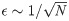
Imprecise balance under optogenetic stimulation.a) Schematic. A population of recurrently connected excitatory (red) and inhibitory (blue) spiking neuron models receive synaptic input from an external population (X; green) of Poisson-spiking neurons. Optogenetic stimulation of excitatory neurons was modeled by an extra inward current to the excitatory population at 5s. b) Spike rasters from 50 randomly selected excitatory (red) and inhibitory (blue) neurons from recurrent network. c) Average firing rate of excitatory (red) and inhibitory (blue) neurons in the recurrent network from simulations (light solid), from the balanced network approximation (Eq (3); solid dark) and from the corrected approximation (Eq (4); dashed). d) Mean synaptic currents to 200 randomly selected excitatory neurons in the recurrent network from external inputs (X; green), from the local population (E + I; purple) and the total synaptic current (black). Currents are measured in units of the neurons’ rheobase (rheobase/Cm = 10.5 V/s). e) Mean firing rates plotted against mean input currents to all neurons in populations E and I (gray dots) and a rectified linear fit to their relationship (black line). f) Mean firing rates from identical simulations without stimulation except the total number of neurons, N, in the recurrent network was modulated while scaling synaptic weights and connection probabilities so that ϵ∼1/N (see Methods). Solid light curves are from simulations, solid dark from Eq (3), and dashed from Eq (4).